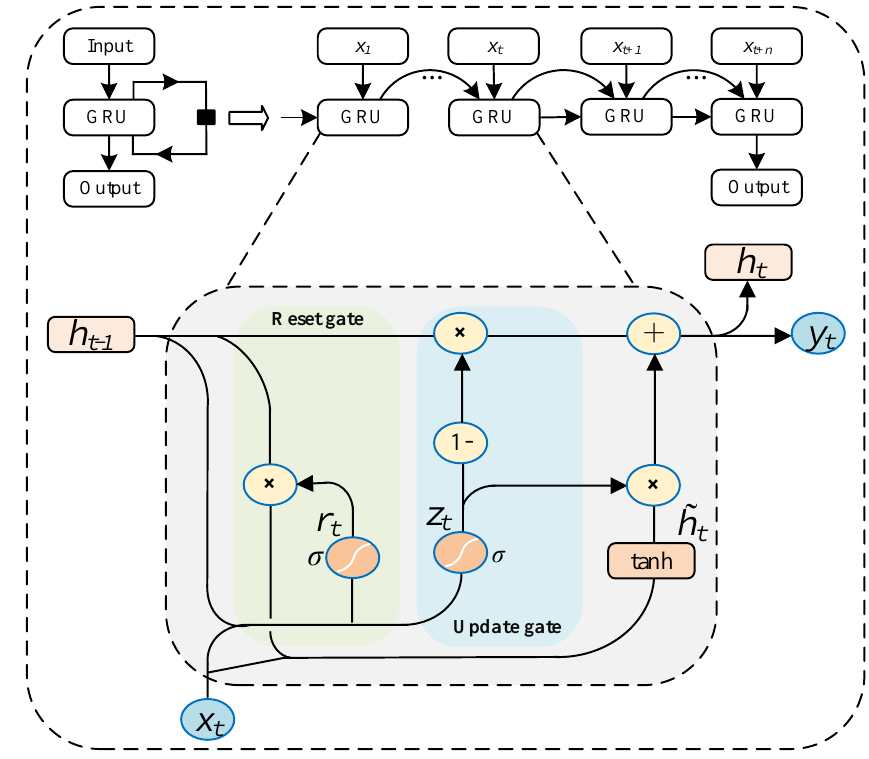
Figure 5. Architecture of the GRU.